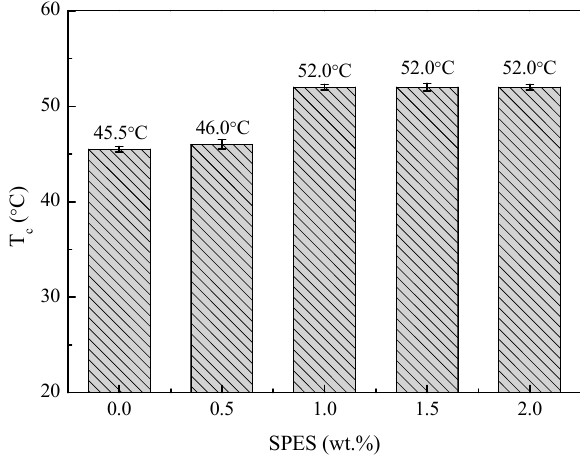
Figure 1. Cloud points of different PES/SPES/DMAc/PEG200 casting solutions.